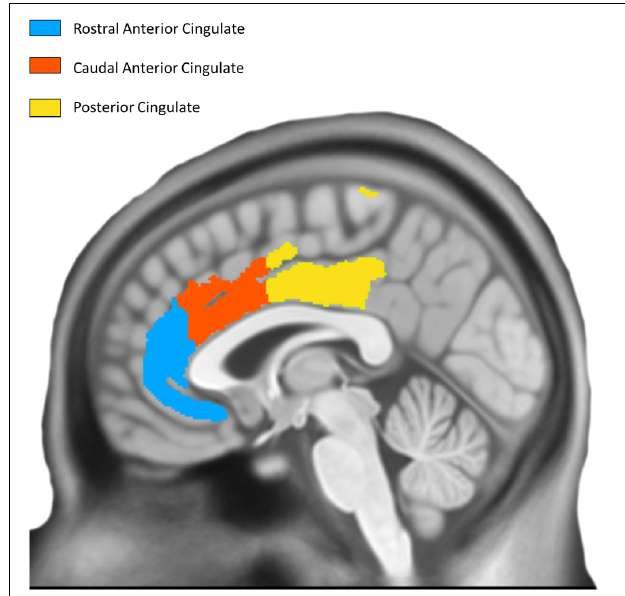
FIGURE 2 | Desikan Killiany Tourville Atlas Three bilateral a priori cingulate regions derived from DKT atlas; left hemisphere is